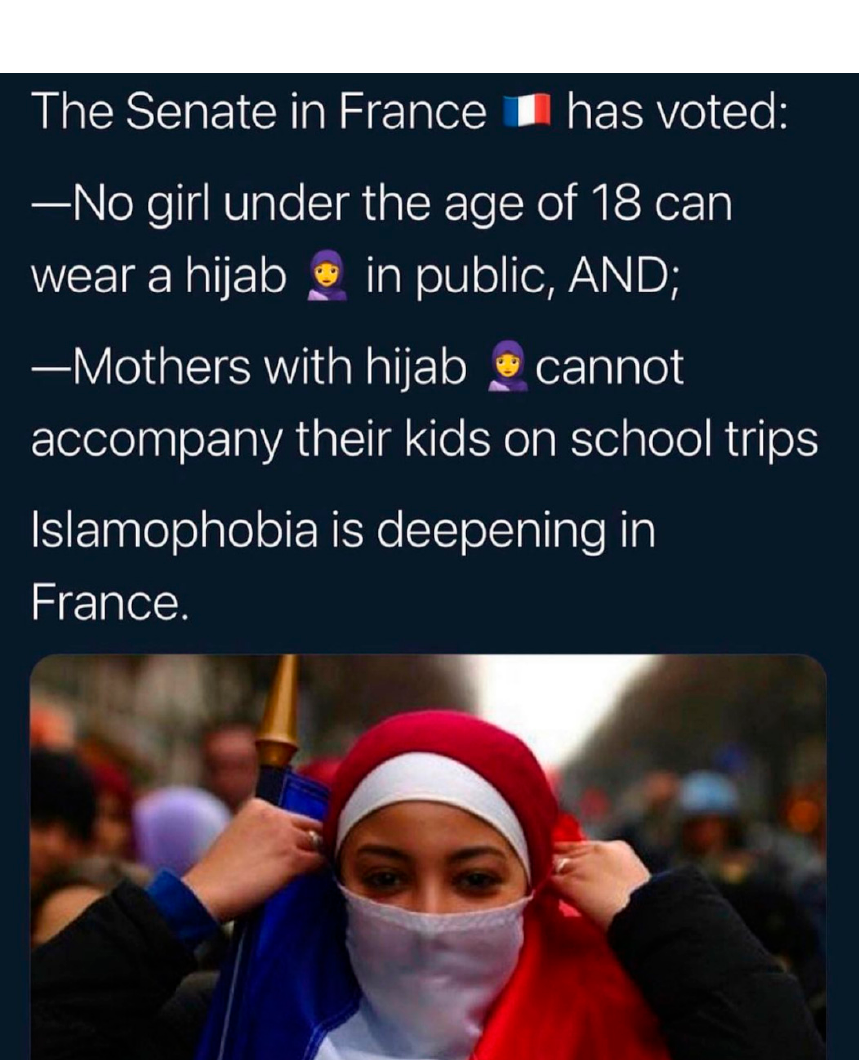
Figure 1. Posting of Ibtihaj Muhammad on Instagram cited after Al Jazeera (2021). Error! Reference source not found.